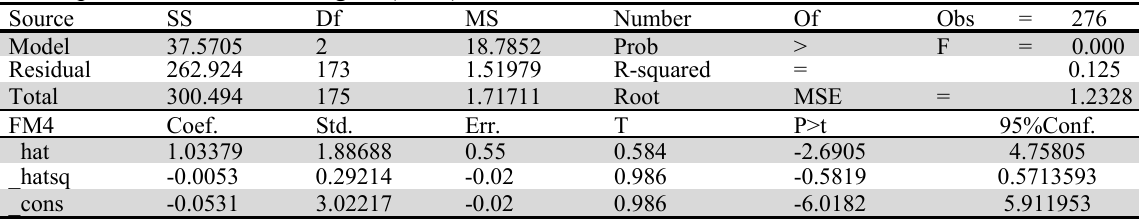
Development of financial budgets (FM4)